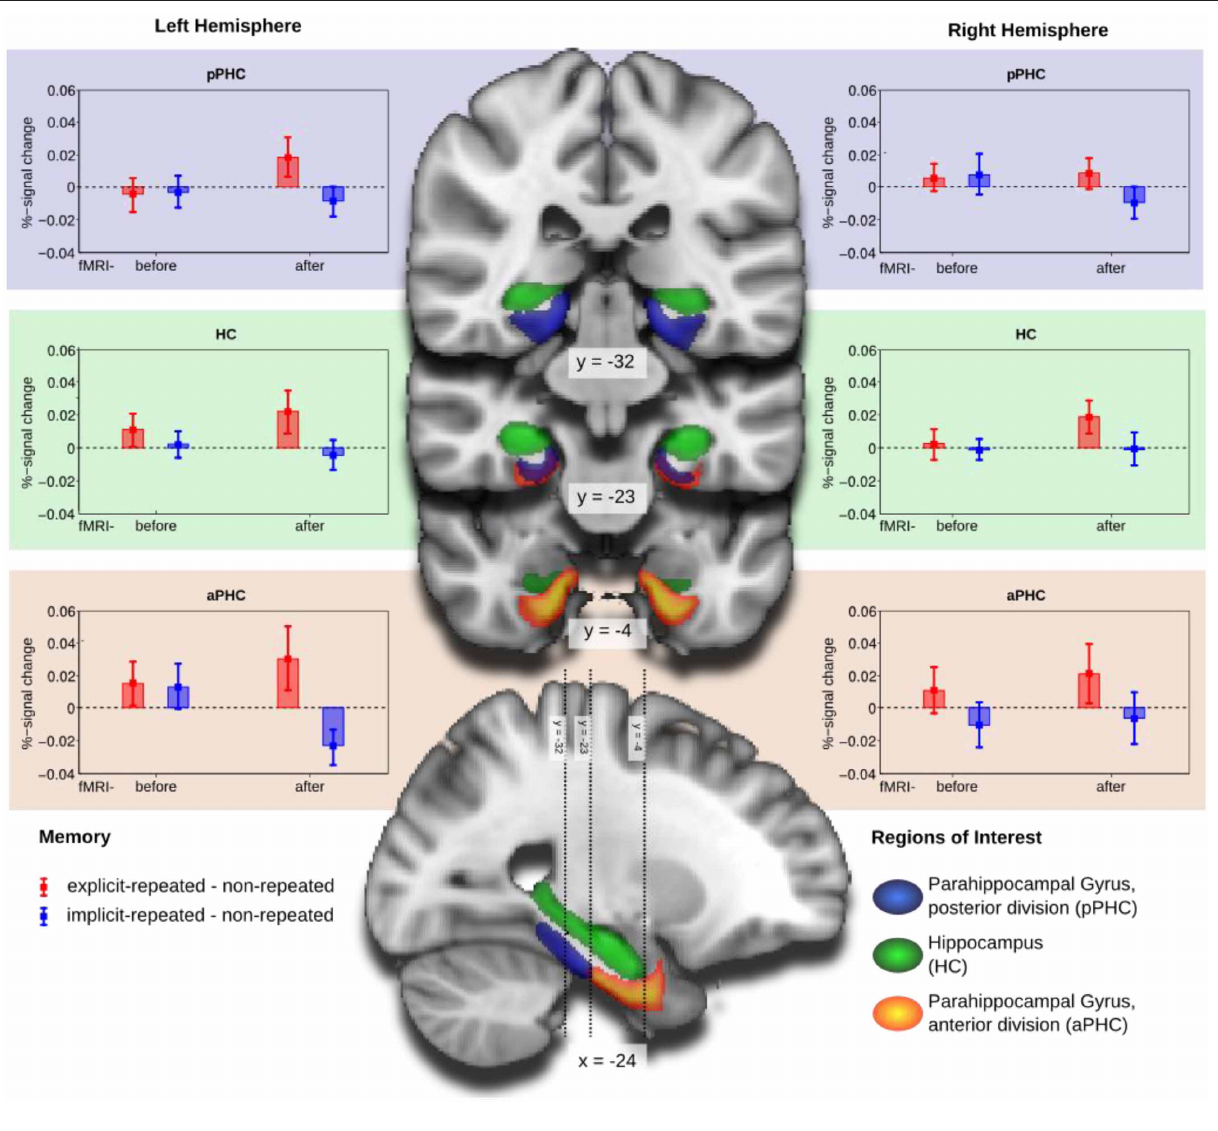
and parahippocampal gyrus, anterior division (pPHC; lower row), separately for the left (left column) and right (right column) hemispheres. Groups are fMRI-before- and fMRI-after-learning. ROIs are projected on coronal slices and one sagittal slice of a standard